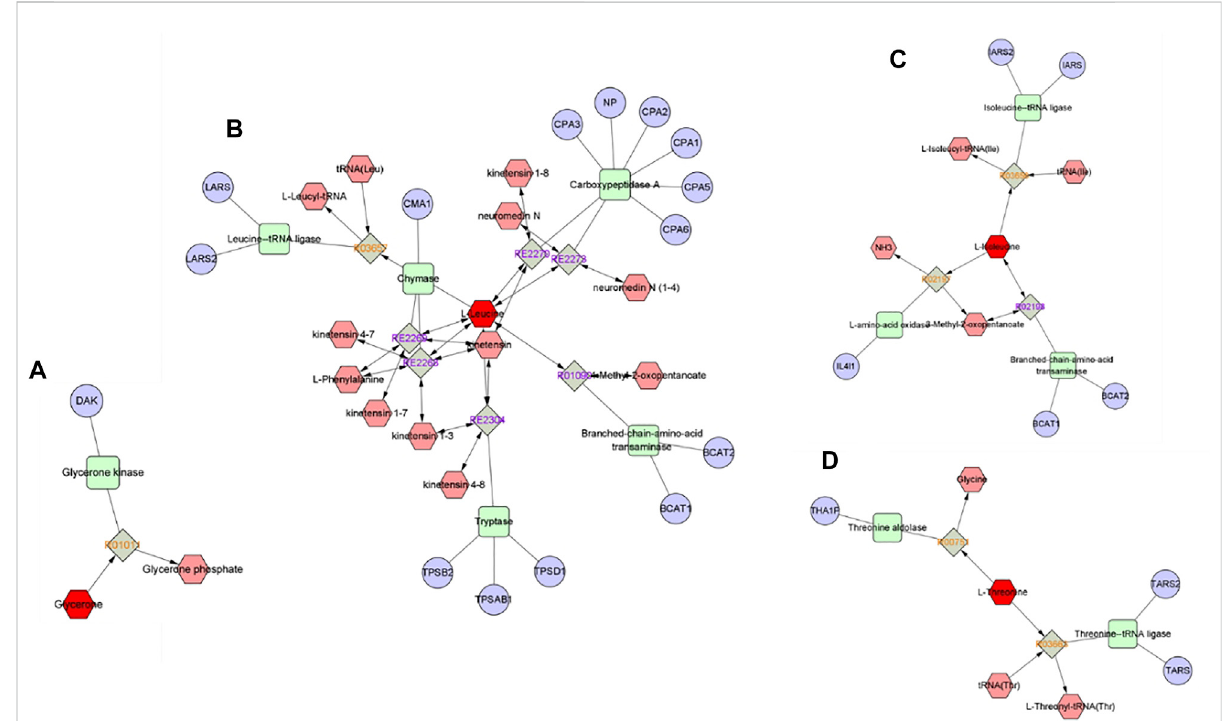
FIGURE 4 PathwayandnetworkanalysesofthemetaboliteswereperformedusingMetascape. (A) Dihydroxyacetone/glycerone (B) Leucine (C) Isoleucine (D) Threonine.Themetabolitesareshowninredhexagons.Graysquare:ReactionnodewithreactionID;Paleredhexagon:Compoundnode;Green square: Enzyme node; Blue circle: Gene node.